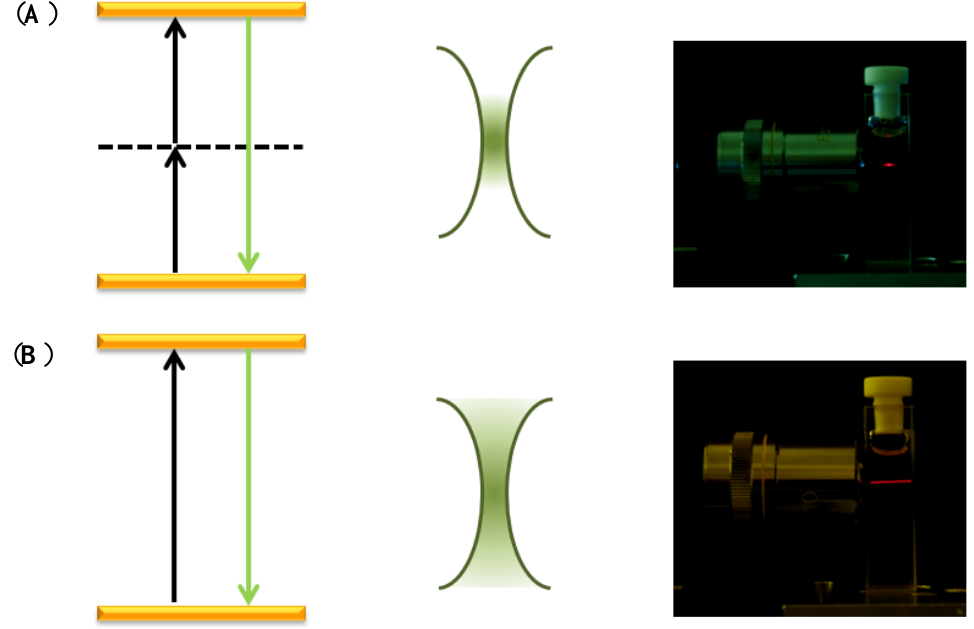
Figure 2. Schematic explanation of the increment of the spatial resolution achieved by using ( A ) two-photon upconversion processes when compared to ( B ) a single photon absorption process. The energy level represented by the solid line may represent either a real or a virtual intermediate state (such as in the case for quantum